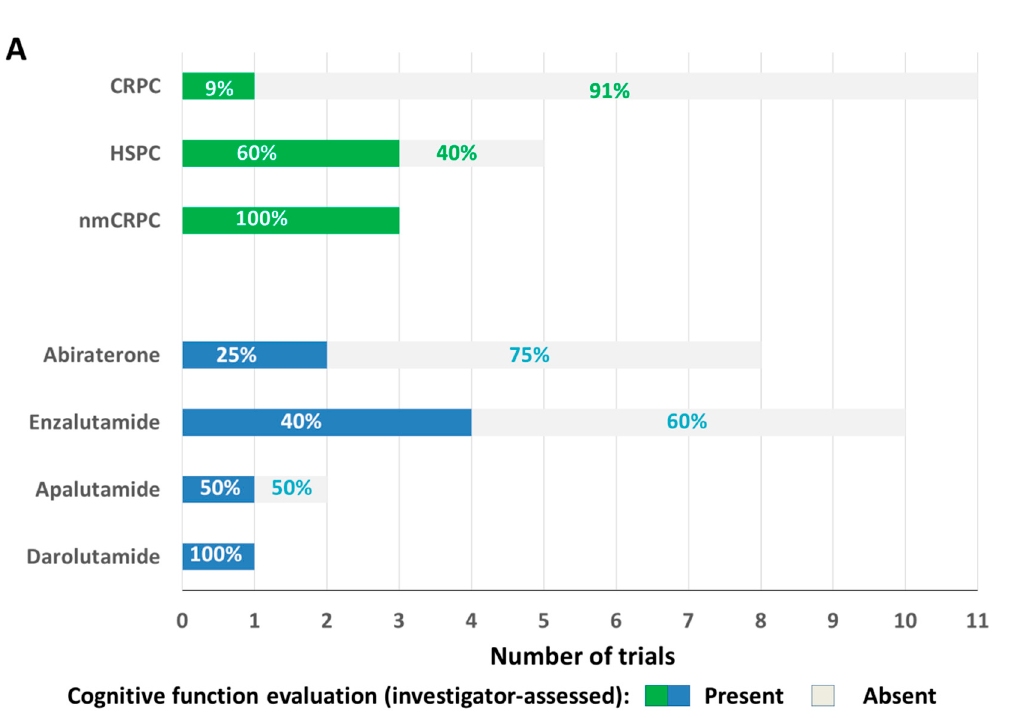
Figure 1. Availability of evaluation of cognitive function based on investigator assessment ( A ) and patient-reported outcomes ( B ) in the randomized trials (RCTs) of new-generation hormonal therapies. 8. Trials Testing Abiraterone Abiraterone acetate has an anti-androgenic mechanism of action. It is converted in vivo to abiraterone, which inhibits 17 a-hydroxylase/C17,20-lyase (CYP17), an enzyme required for androgen biosynthesis.